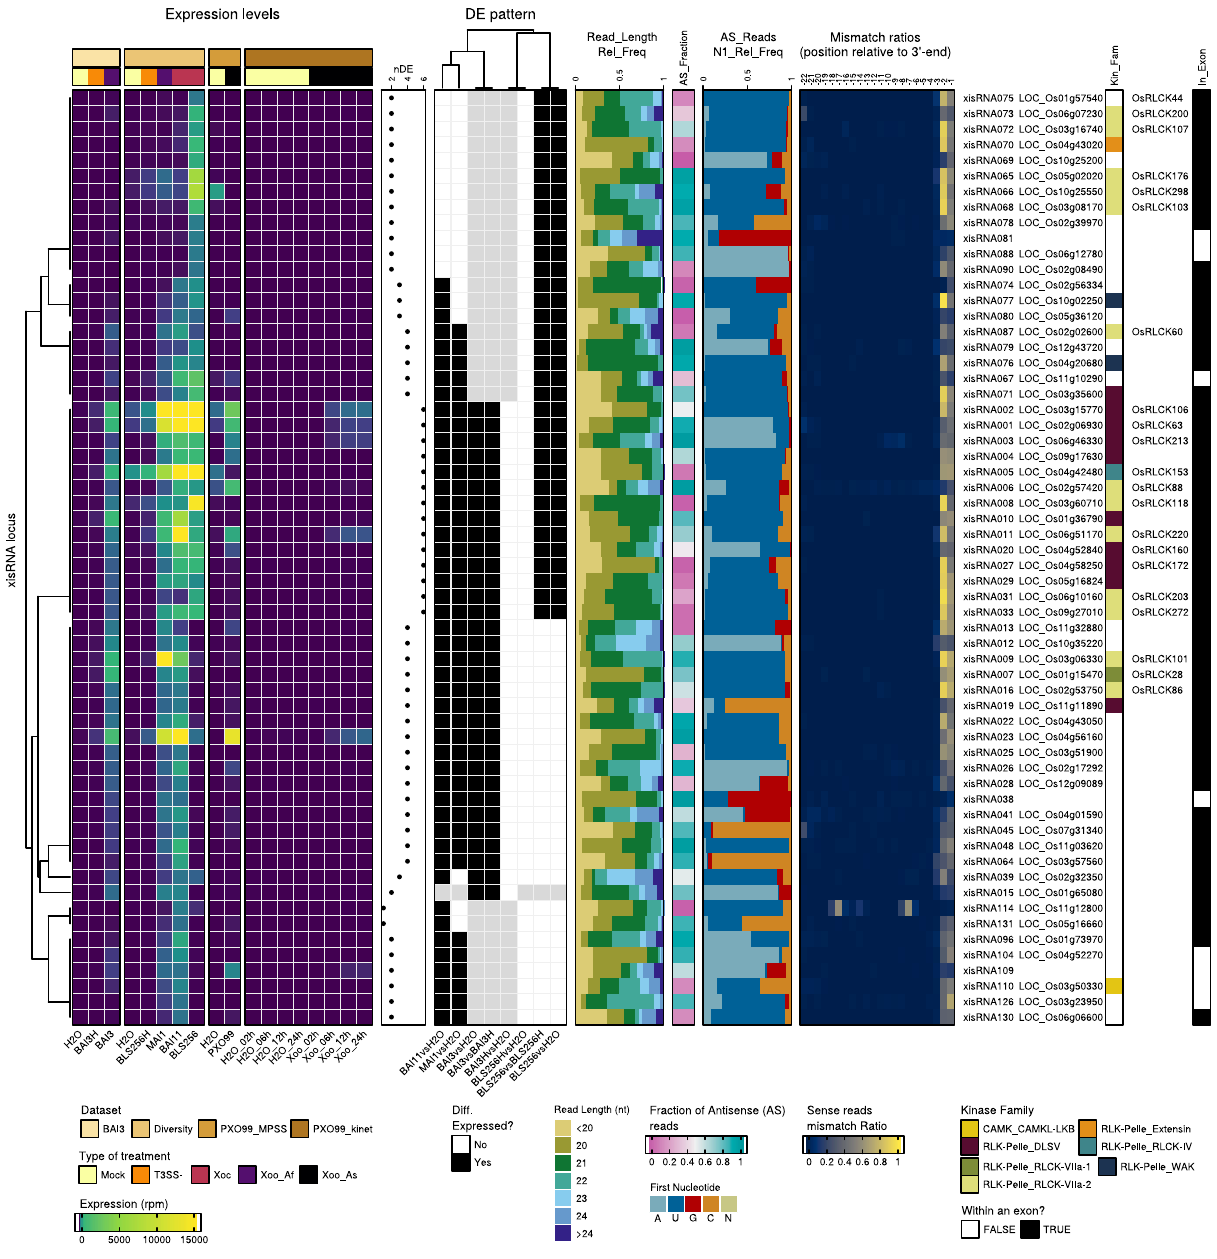
Figure 3. A summary of xisRNAs features in the analyzed sRNA-seq datasets. In the complex heatmap layout, the top 60 xisRNA loci with the highest maximum treatment mean expression across datasets are described row-wise. The first component, on the left, reports on expression (reads per million) in the various inoculation treatments of the different datasets. In the type of treatment legend, the “Xoo_Af” and “Xoo_As” labels stand for African Xoo and Asian Xoo strains, respectively. The DE patterns component shows whether xisRNA loci were detected as DE in various comparisons. The “nDE” dot plot depicts the number of comparisons where the xisRNA locus was deferentially expressed. Cells in gray indicate that the xisRNA locus was not considered in the dataset because the loci was not detected by ShortStack or because reads in this dataset did not pass our xisRNA loci features criteria. The subsequent plots on the right depicts the size distribution of reads (“Read_Length_Rel_Freq”), the fraction of antisense reads (“AS_Fraction”), the proportion of antisense reads with distinct 5 ′ -end first nucleotide (“AS_Reads_N1_Rel_Freq”) and the specific nucleotide mismatch ratios for relative positions − 22 to − 1 of antisense reads using xisRNA loci mapping reads from the “BAI3” and “Diversity” datasets. The MSU7 identifier of the gene overlapping with a xisRNA duplex locus is indicated together with the kinase subfamily into which the encoded protein is classified (“Kin_Fam.” column) as well as the RLCK protein name, when relevant and available. Finally, the “In_Exon” column indicates whether the xisRNA duplex loci is fully included in an exon of an annotated mRNA of the gene. All numerical values reported in the graphic were computed using reads mapping to the xisRNA duplex loci. Note that the antisense polarity is defined relative to the orientation of the underlying cis -gene. To compute values that incorporate a notion of polarity for xisRNA loci that do not overlap with an annotated gene, reads mapping to the top strand were arbitrarily considered to be in the sense